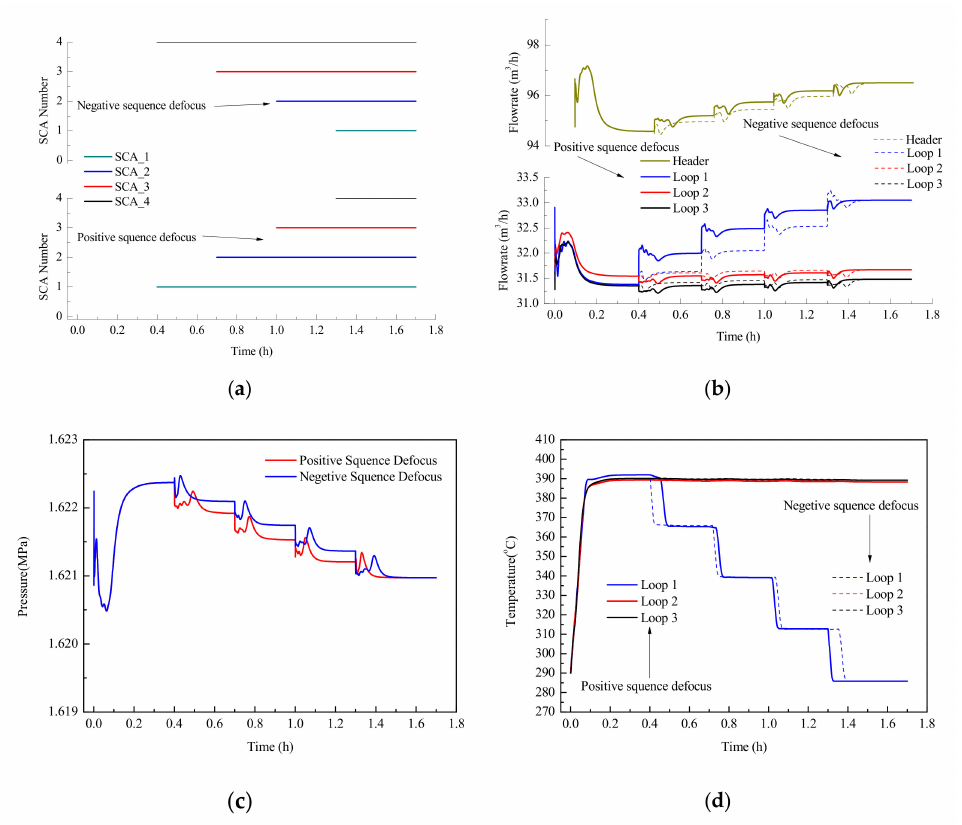
Figure 17. Simulating Case 2 for ( a ) initial parameters; ( b ) inlet flowrate results of the header and three loops; ( c ) pump pressurizing results; and ( d ) outlet temperature results of three